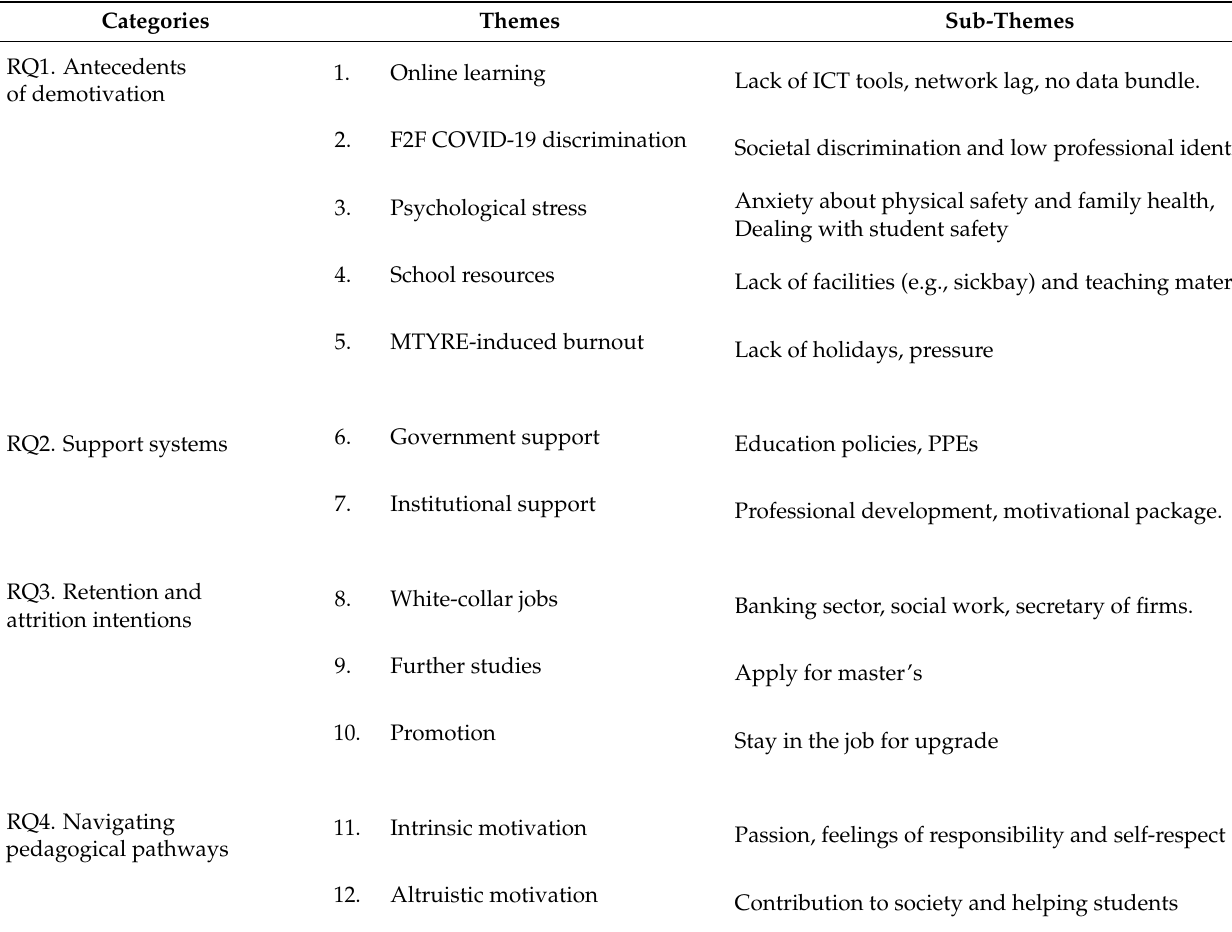
Table 1. Categories, Themes, and